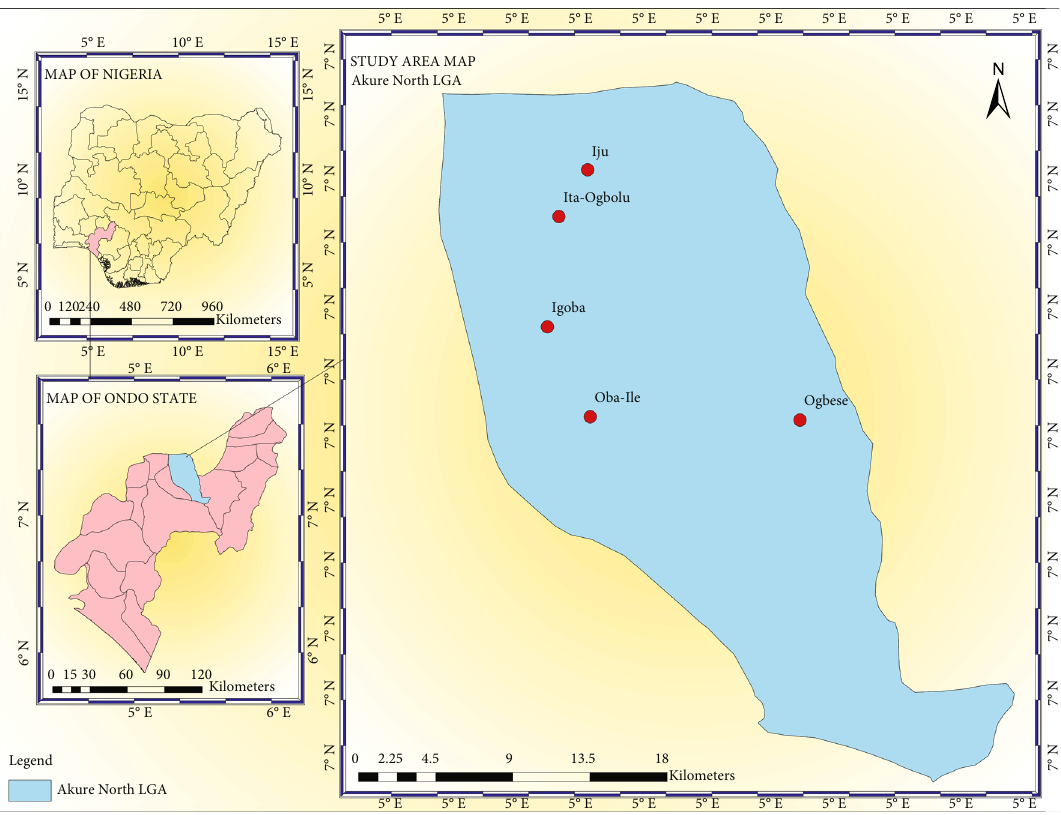
Figure 1: Map of Akure North Local Government Area of Ondo State, Table 1: Prevalence of COVID-19 according to month in Akure North Local Government Area of Ondo State, Nigeria.